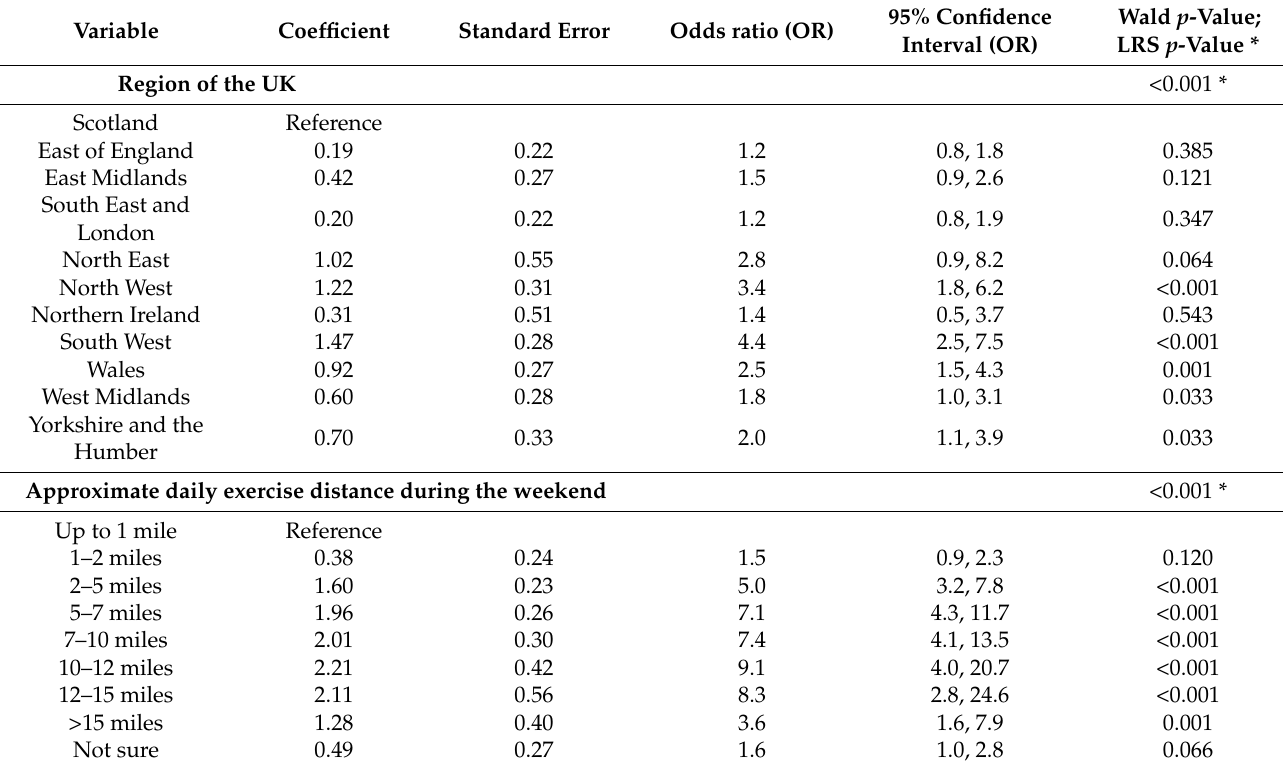
Table 3. Multivariable logistic regression modelling to identify factors associated with road use by UK’s equestrians (based on responses from 4842 equestrians in October